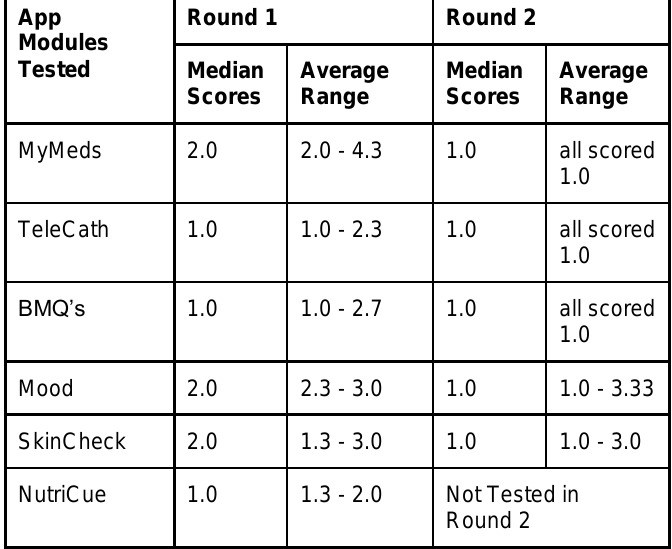
Table 2. Comparison of PSSUQ Scores from Phase